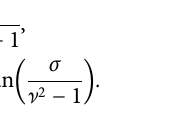
Frontiers in Physics |